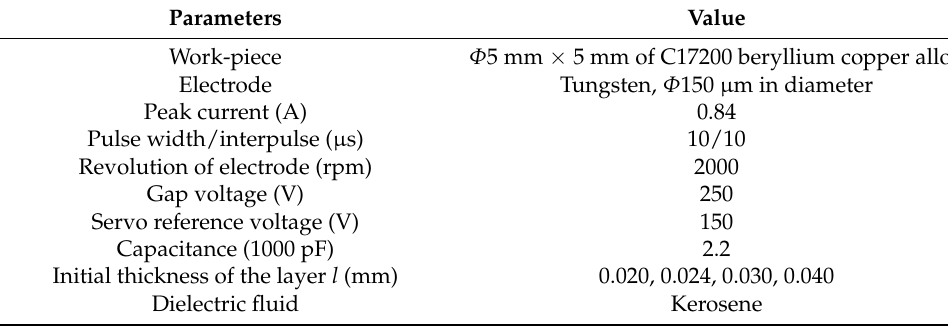
Table 1. Machining conditions for experiments.